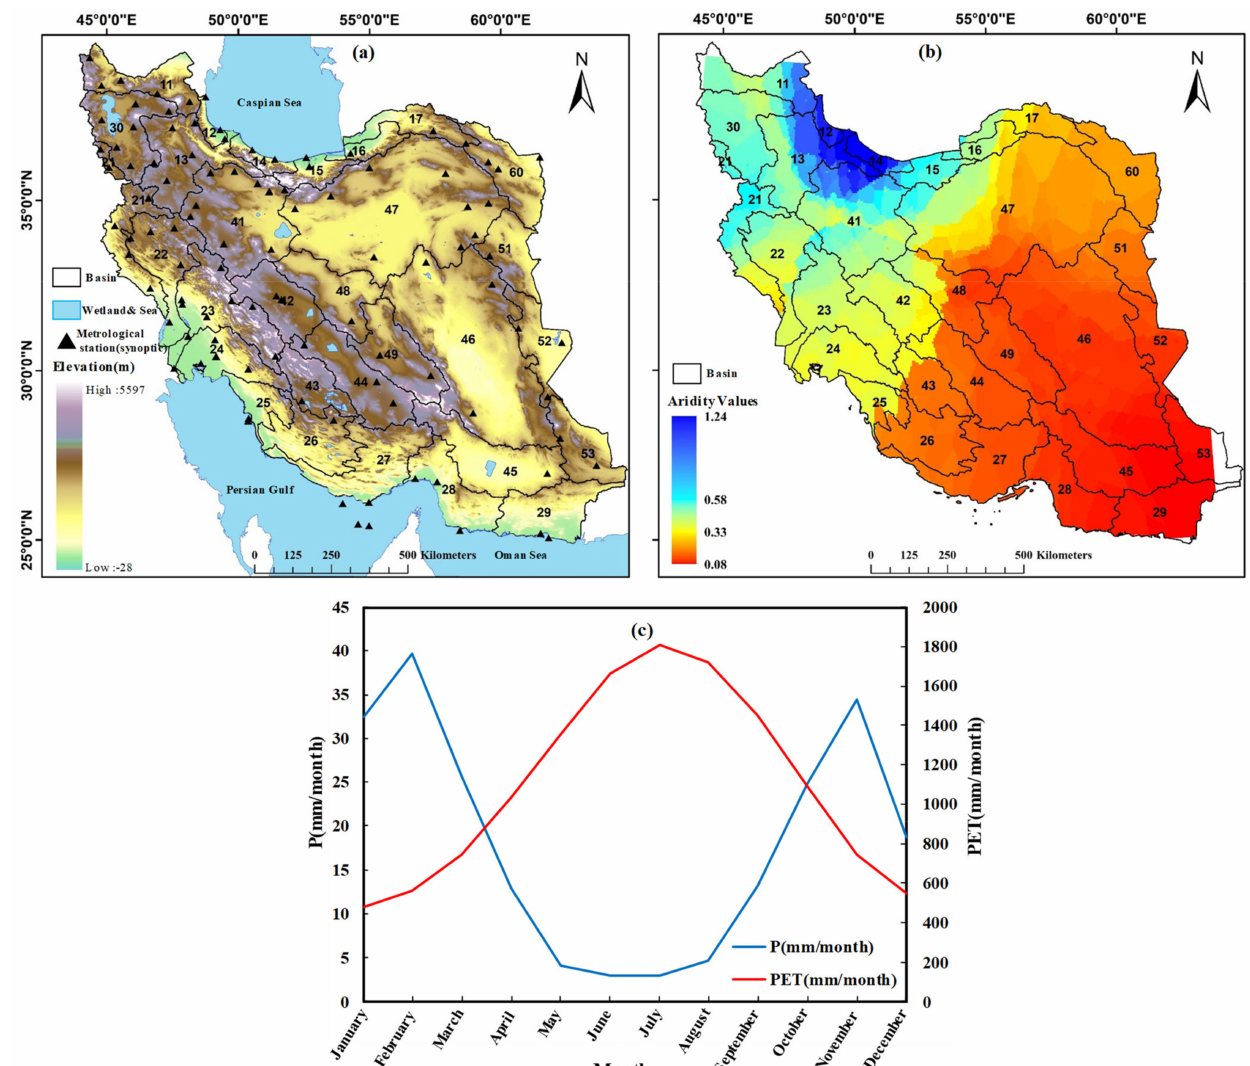
Figure 1. ( a ) A: Digital elevation model (DEM) of Iran, location of its 30 main basins and spatial distribution of synoptic stations, ( b ) climate classification of Iran based on aridity values (UNEP, 1997), and ( c ) mean monthly precipitation (P) and mean potential evapotranspiration (PET) in Iran